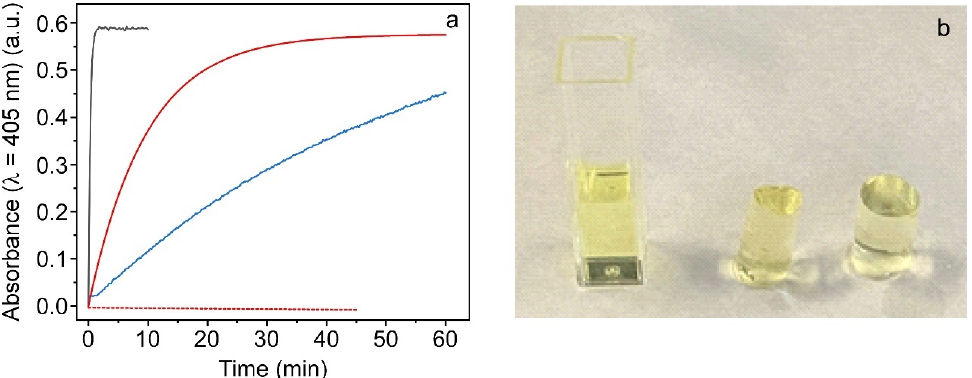
Figure 3. ( a ) Kinetics of PNP production by ALP in solution (black), ex situ (red) and in situ (blue) ALP@AETA hydrogels in 50 µ M PNPP presence. The dashed red line represents a hydrogel in the absence of ALP to which PNPP has been added. ( b ) Comparison of the visual appearance of ALP in solution, ALP@AETA ex situ and in situ hydrogels (from left to right) after incubation with 50 µ M PNPP for 20